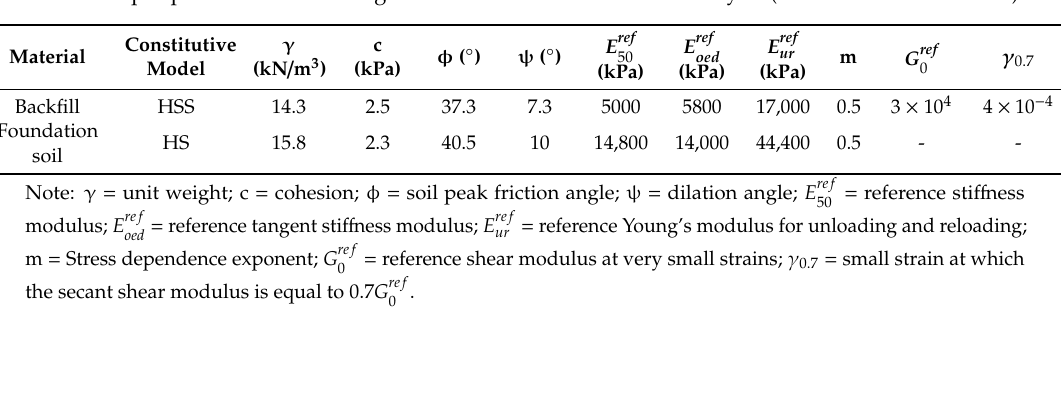
Table 3. Input parameters of the large-scale test wall for validation analysis (backfill and